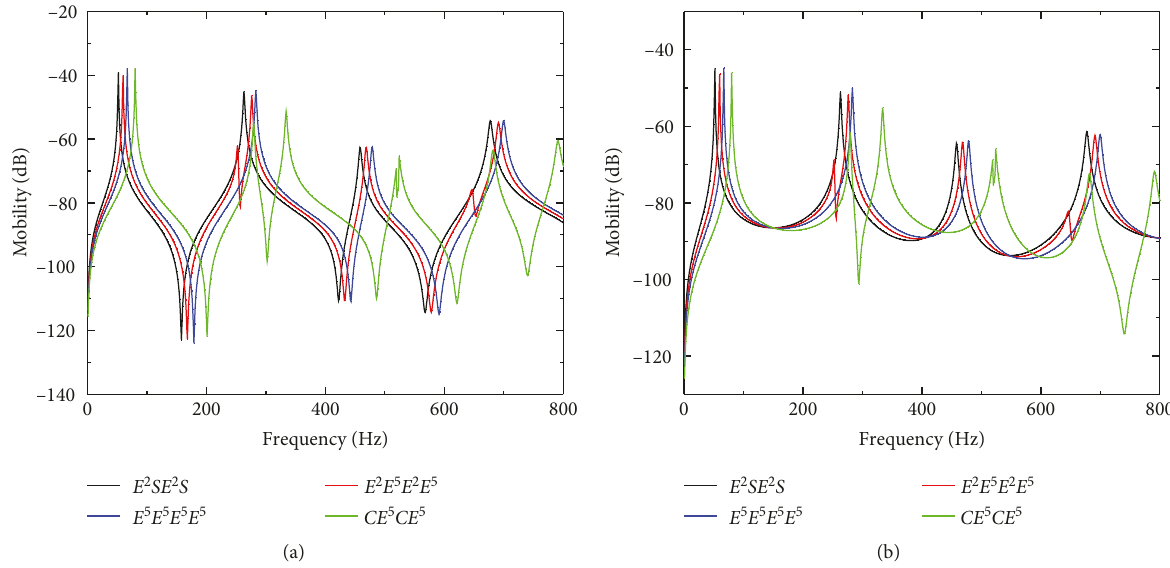
Figure 8: Mobility characteristics of diagonally stiffened square plate subjected to local uniform pressure with various elastic boundary conditions ( p w � 1). (a) Point C (0.5m, 0.5m). (b) Point D (0.25 m, 0.25